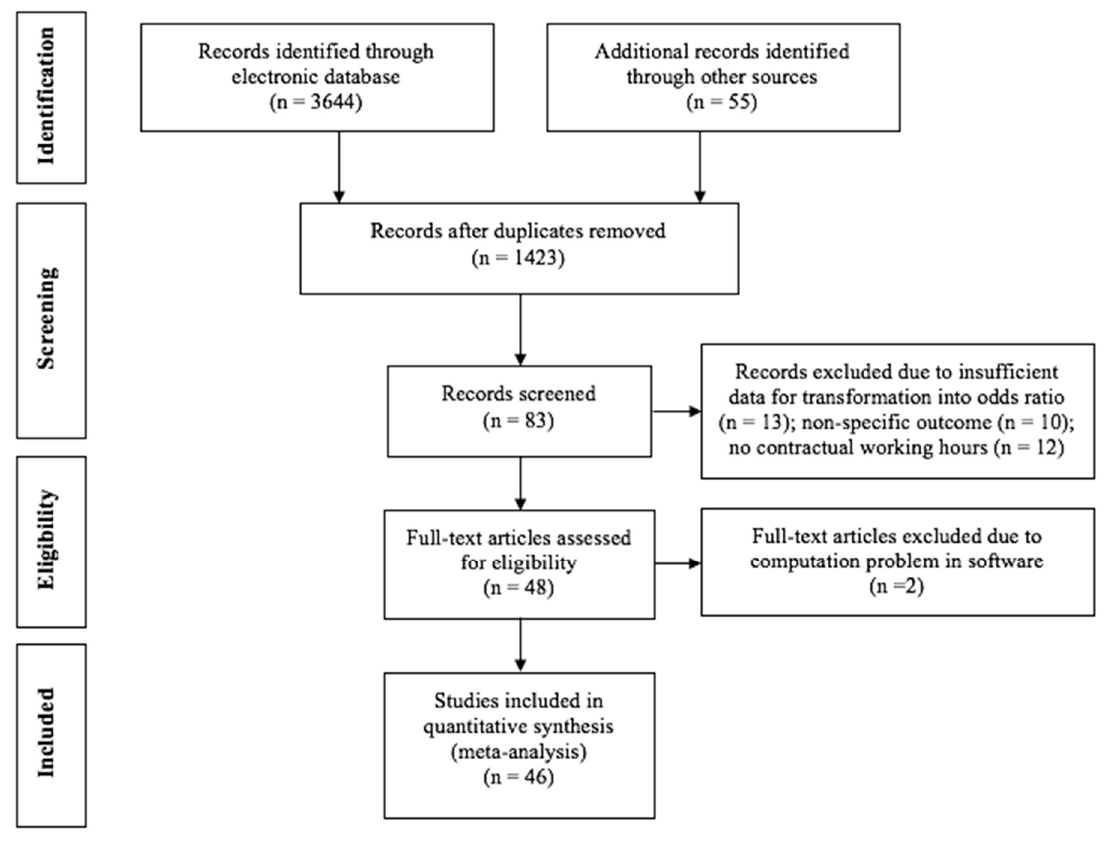
Figure 1. Flow diagram of the study selection process.